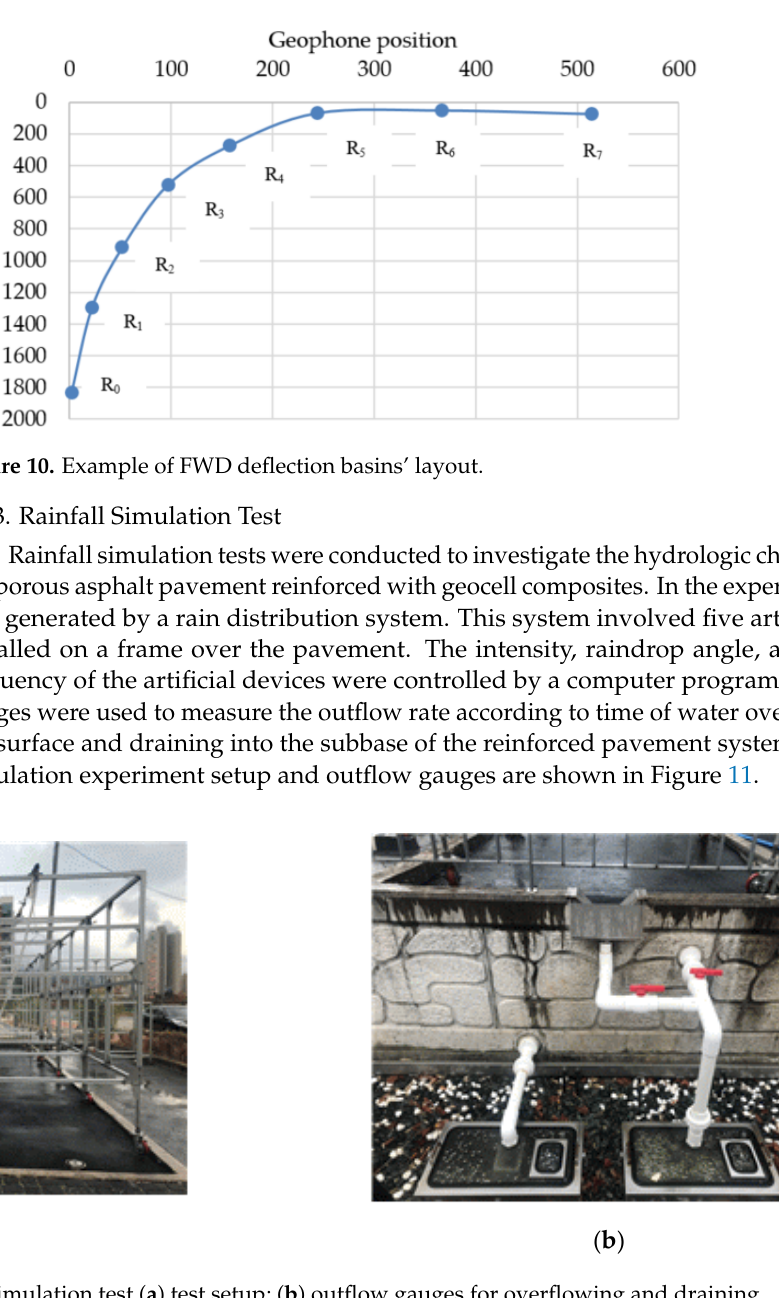
Figure 9. FWD geophone position.